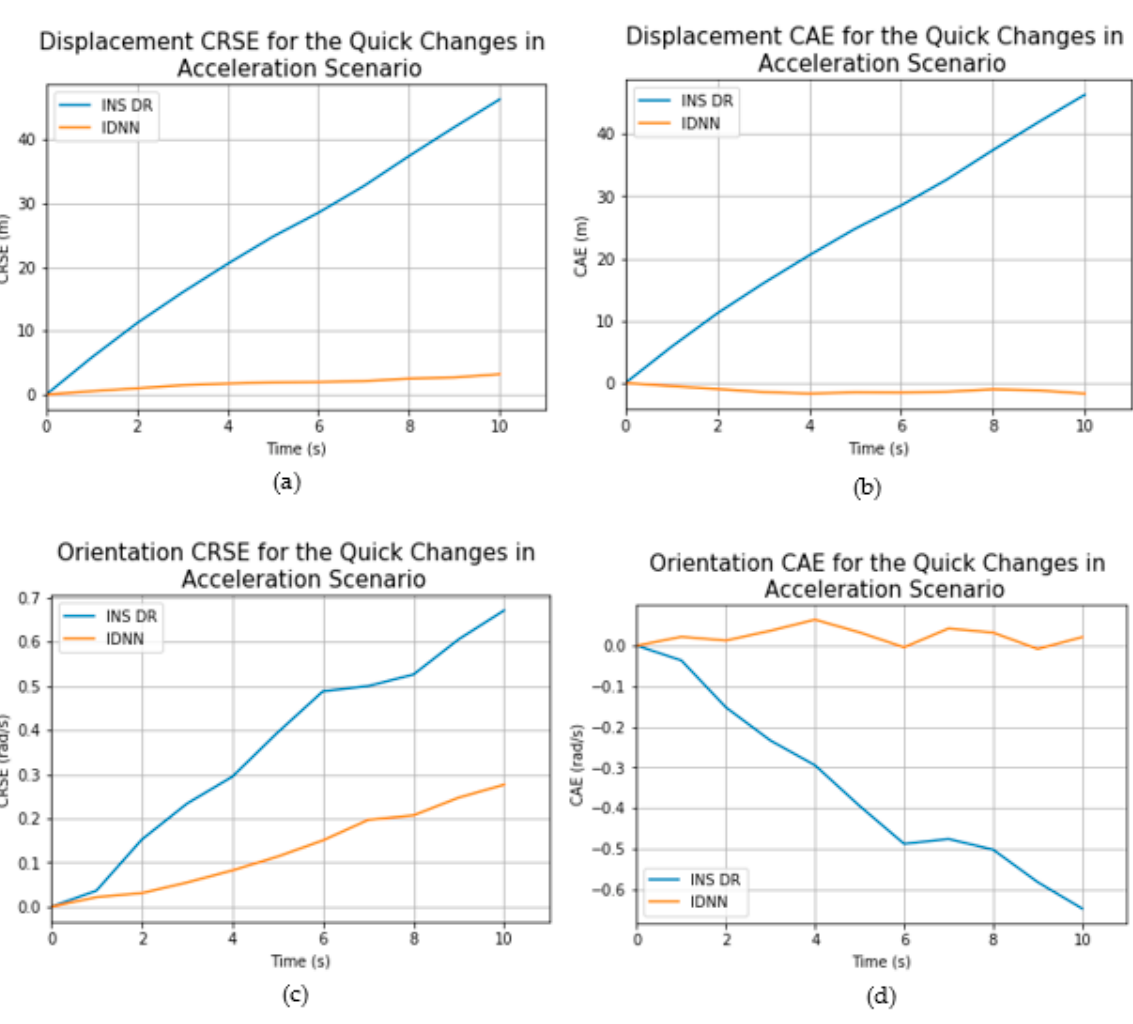
Figure 10. Showing the evolution of the estimation error over time in the quick changes in acceleration scenario based on the ( a ) Displacement CRSE, ( b ) Displacement CAE, ( c ) Orientation rate CRSE and ( d ) Orientation rate CAE. Table 11. Showing the performance of the IDNN and INS DR on the quick changes in acceleration